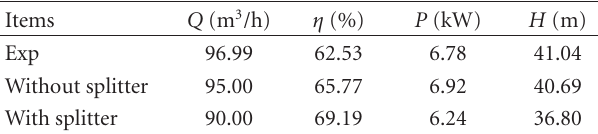
Table 2: BEPs of experimental and numerical